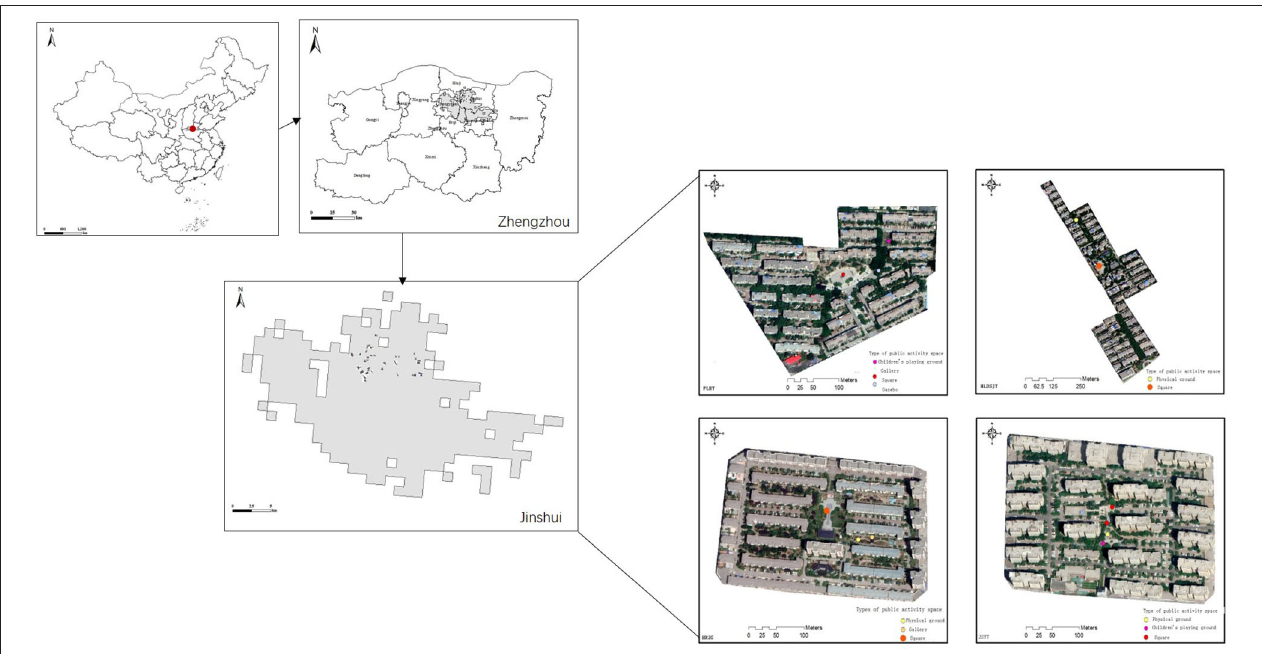
FIGURE 1 | The geographical locations of the selected 40 residential communities.